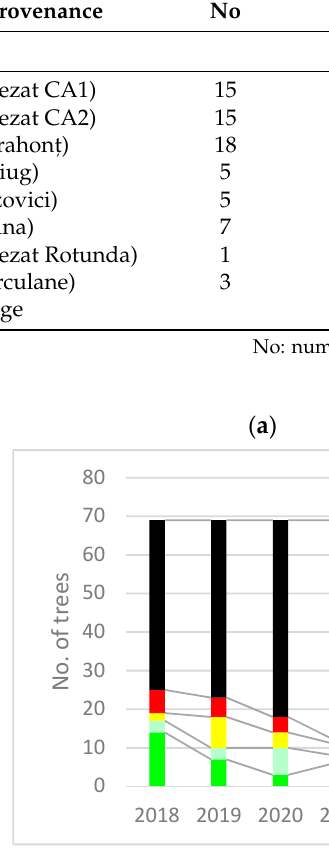
Figure 6. ( a ) Recent defoliation evolution of Ulmus glabra (all provenances); ( b ) Different types of individual evolution of U. glabra defoliation (tree numbers: 57, 2, and 15). The LMMs shows that the #diameter# and the #defoliation# were affected by the provenance ( χ 2 = 17.6, df = 6, p < 0.01 and χ 2 = 26.1, df = 6, p < 0.001 respectively) but not by the year ( χ 2 = 0.45, df = 1, p = 0.49 and χ 2 = 4.9, df = 3, p = 0.17, respectively), nor by the interaction “Provenance x Year” ( χ 2 = 0.9, df = 3, p = 0.99 and χ 2 = 1.5, df = 18, p = 0.99, respectively).